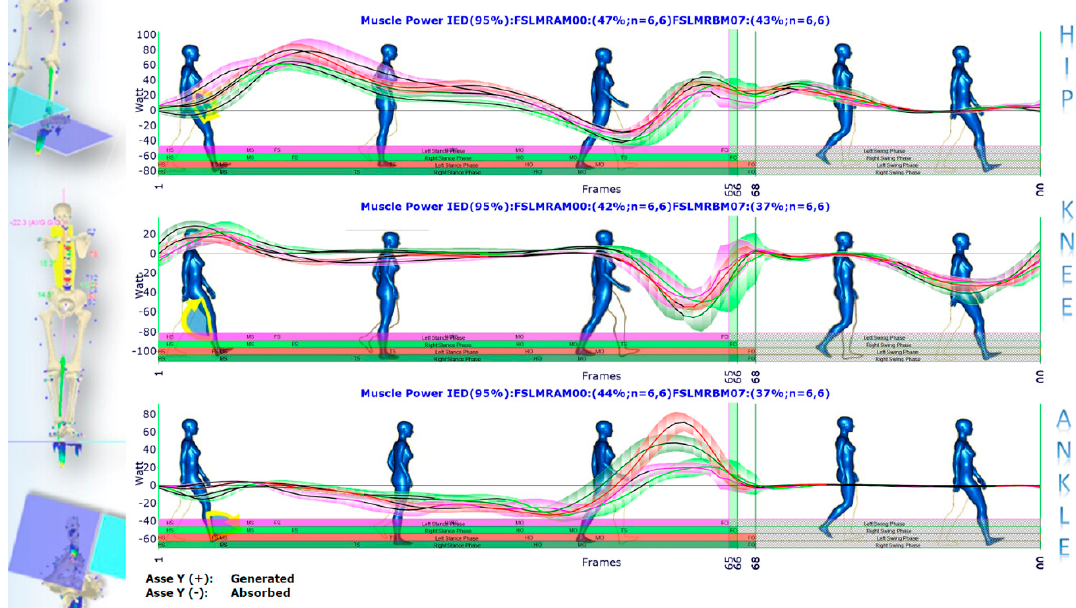
Figure 11. Average gait cycle: muscle power at lower limbs joints. Each panel shows the left (red colours) vs. right leg (green colours) comparison in the following conditions: barefoot walking in the initial evaluation (darker colours, file name code FSLMRAM00) and walking with foot orthosis during the control session (lighter colours, file name code FSLMRAM07). The following information is listed in brackets: (1) IED values; (2) the number of valid strides included in the averaging process. From the IED analysis, it is possible to appreciate the general asymmetry reduction passing from the first to the second condition.